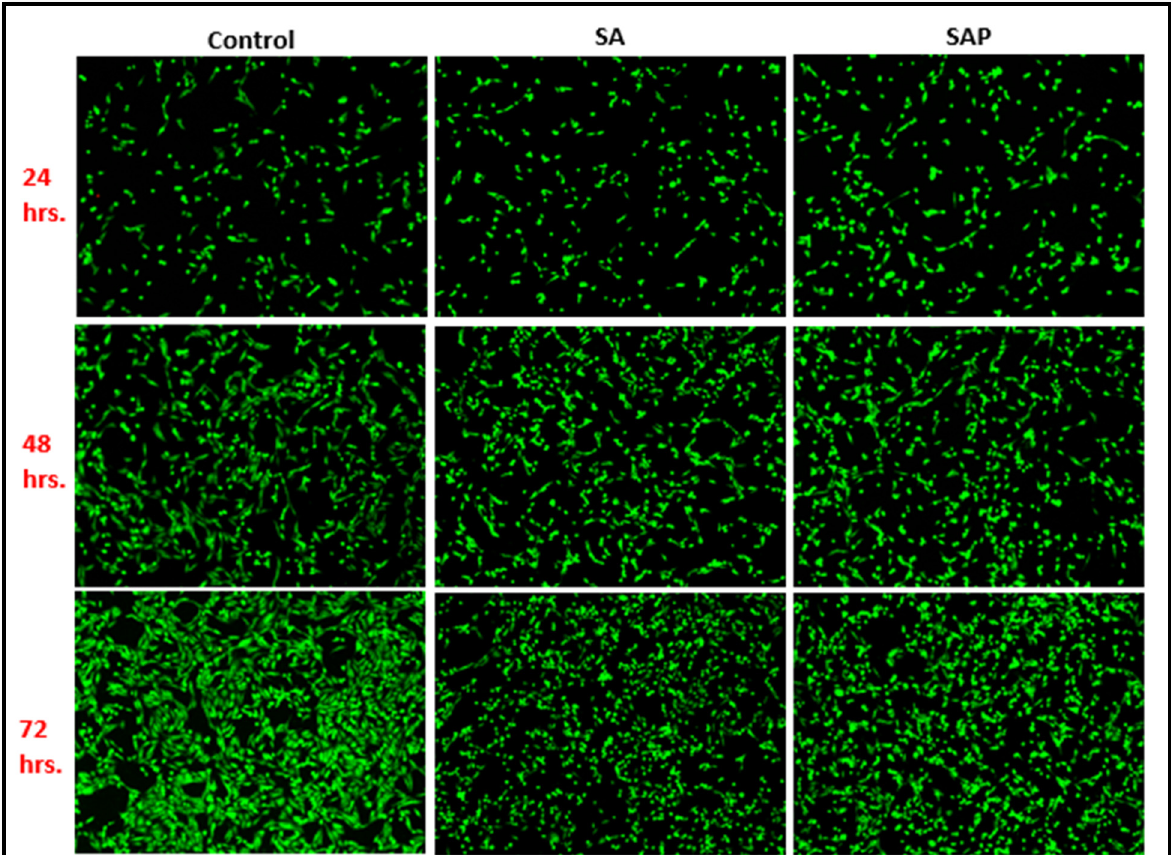
Figure 7. Fluorescence images of MDA-MB-231 cells stained with acridine orange (AO) and propid- ium iodide (PI) in the SA, SAP and control groups for 24 h, 48 h, and 72 h. The green spots staining with AO represent live cells, whereas the red dots staining with PI represent dead or dying cells.